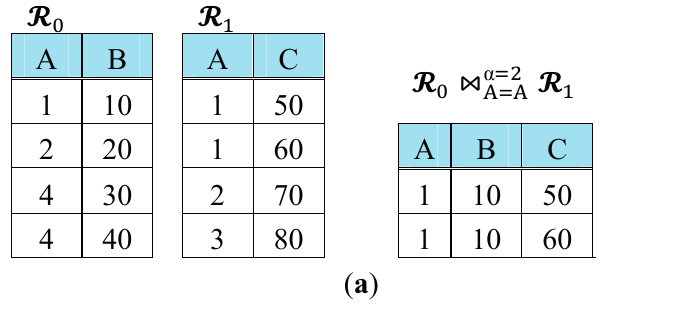
Figure 1. An Example of an Iceberg Join Query. ( a ) Join operand relations (cid:2332) and the result of their iceberg join with α = 2; ( b ) SQL expression retrieving attribute A from the iceberg join in ( a